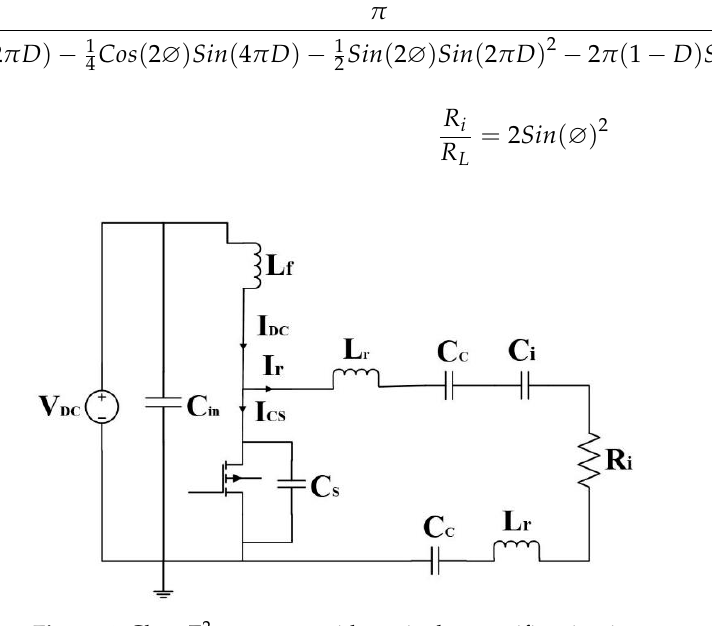
Figure 4. Class-E 2 converter with equivalent rectifier circuit.